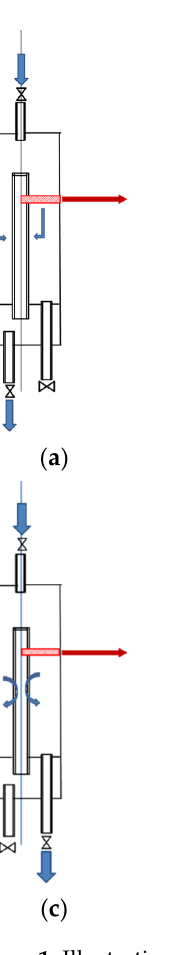
Figure 1. Illustration of the flow structure in the cross section of the membrane catalyst wall in the contactor modes with forced ( a , b ) and “diffusion” ( c , d ) transport. —thermal slip 𝑄 (cid:3021)(cid:3007) (in FT-mode ( a ) and 𝑄 (cid:3021)(cid:3005) (in DT-mode ( c )); —viscous flow 𝑄 (cid:3017)(cid:3007) (in FT-mode ( a ) and 𝑄 (cid:3017)(cid:3005) (in DT-mode ( c )); P и T —temperature and pressure in the internal (“cold”) and annular (“hot”) volumes of the reactor, respectively.